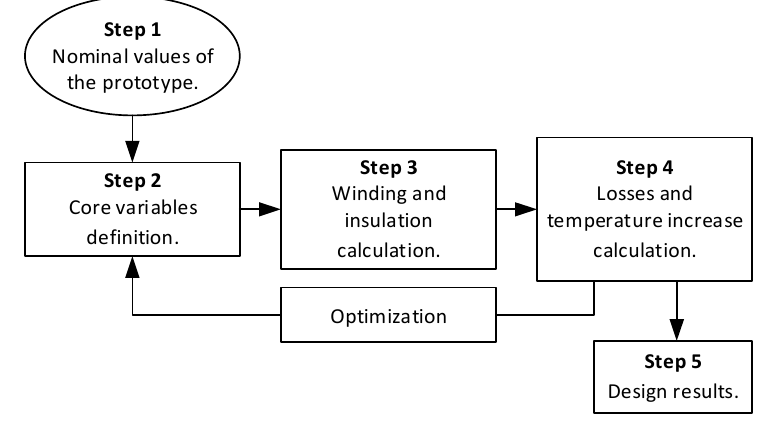
Figure 1. MFT Design methodology.